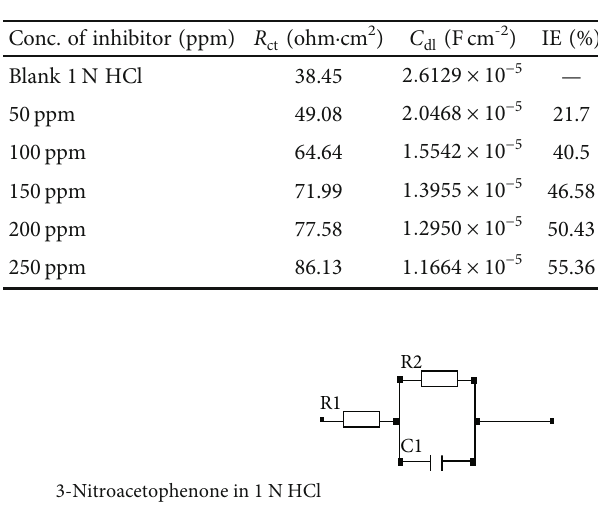
Figure 5: Equivalent circuit for EIS spectra of the studied system.